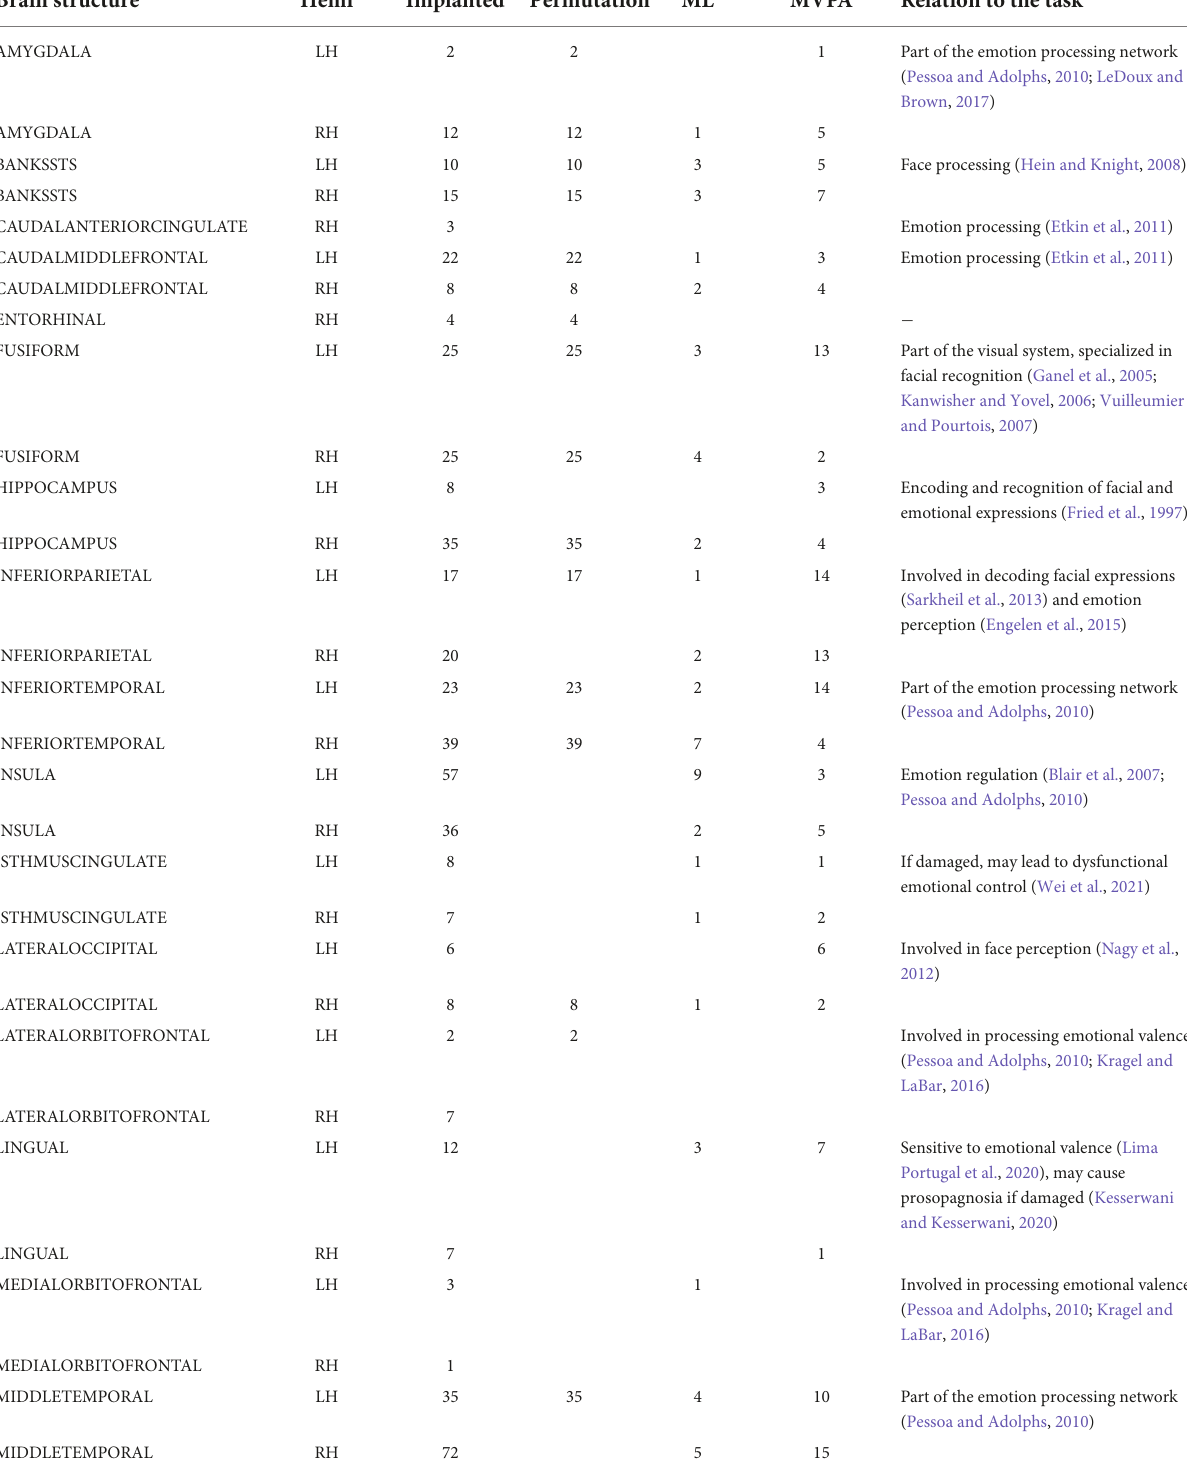
TABLE 3 Per structure distribution of implanted electrode contacts, and the number of significant contacts per each analysis method. Brain